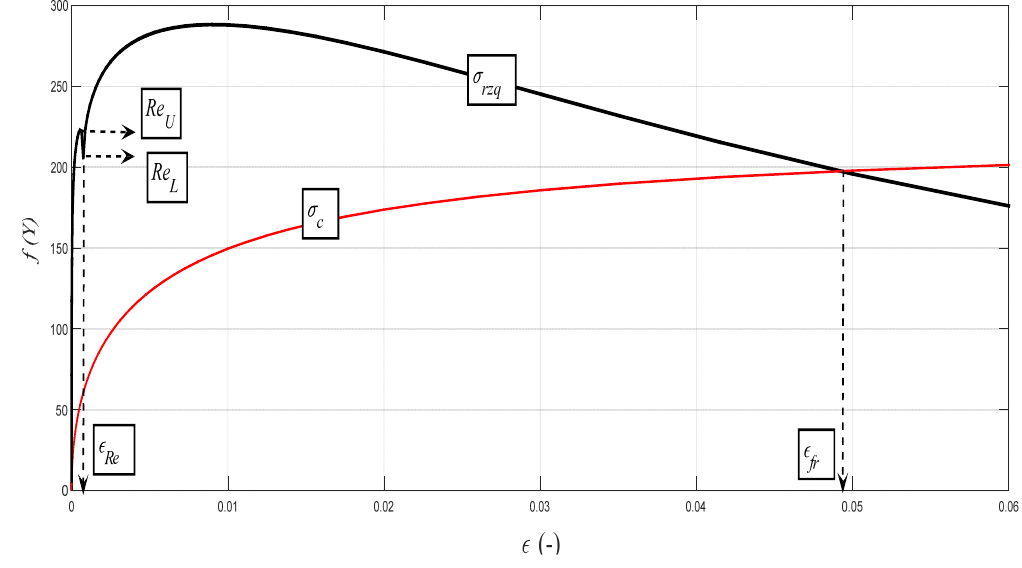
Figure 12. Analytical deformability diagram for the aluminium alloy AW6082T6 for the dependence σ rzq = f ( ε ); detail for Re U and Re L . σ rzq (black color) and σ c (red color).